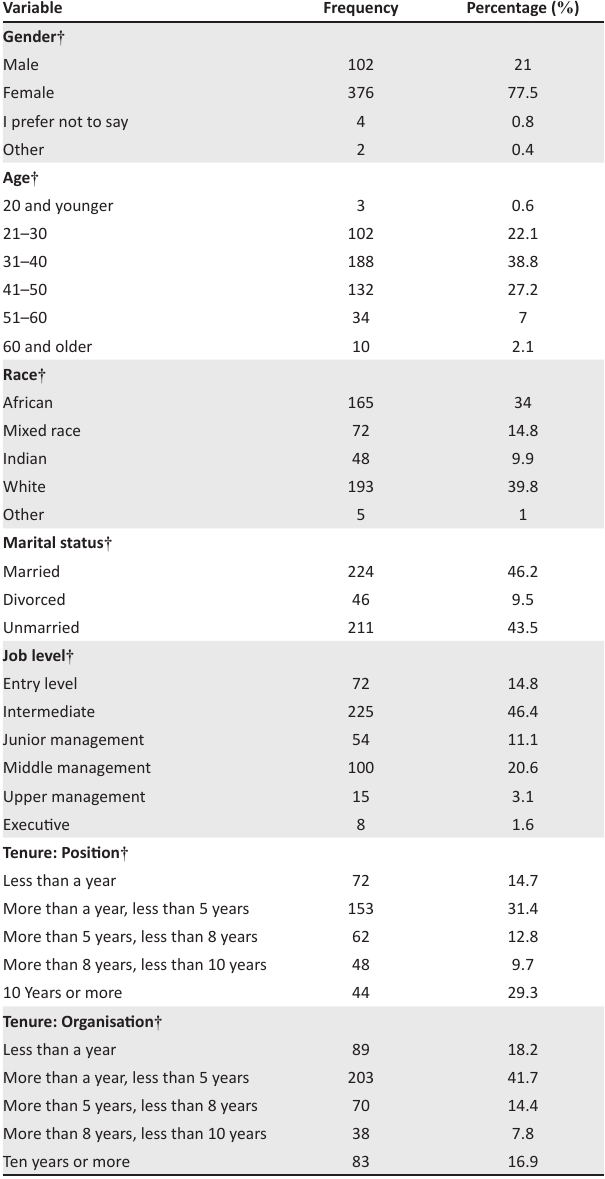
TABLE 1: Descriptive data for sample.